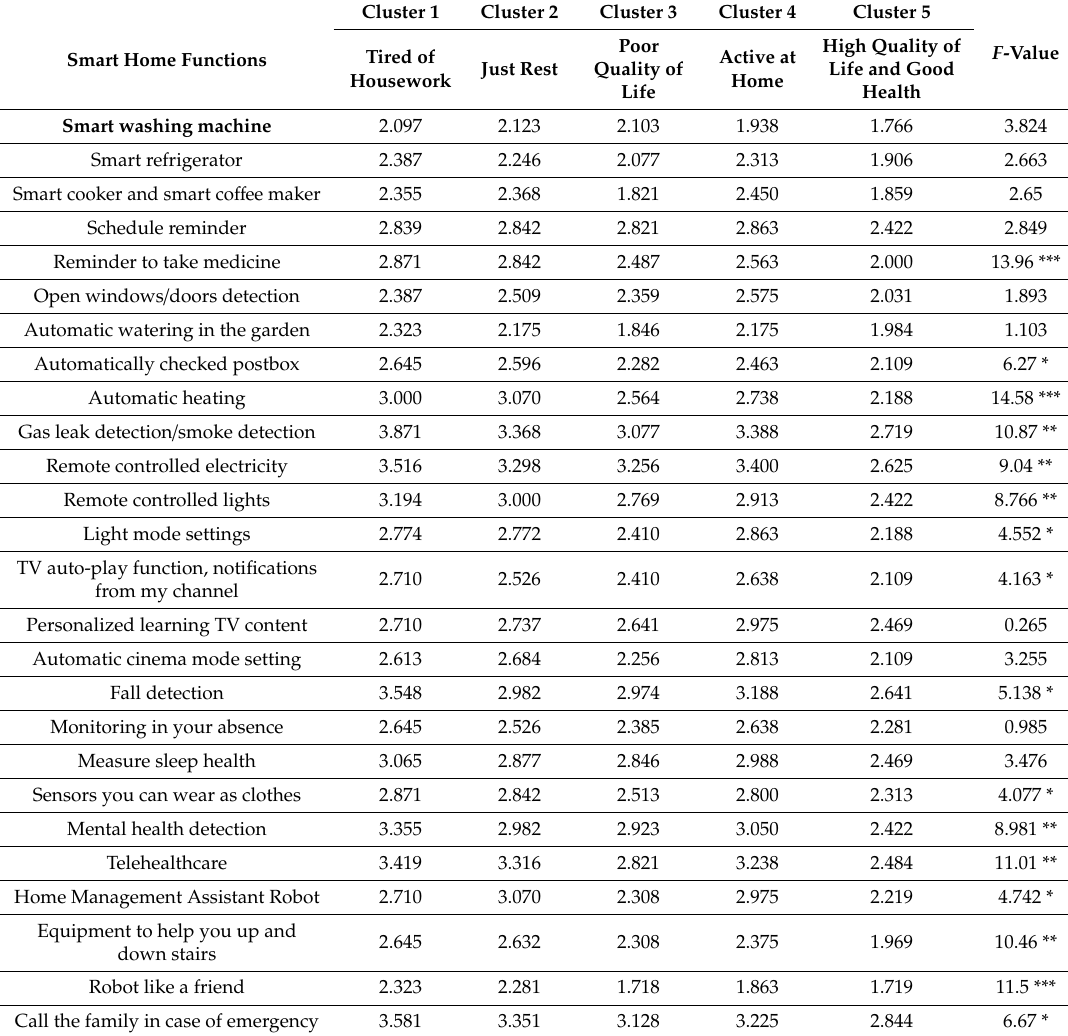
Table 5. The needs for smart home functions for each cluster.